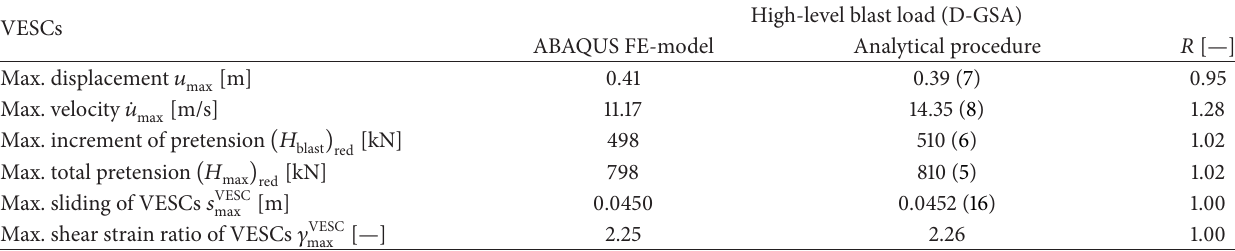
Table 5: Comparison of numerical and analytical results for the fac¸ade-module with